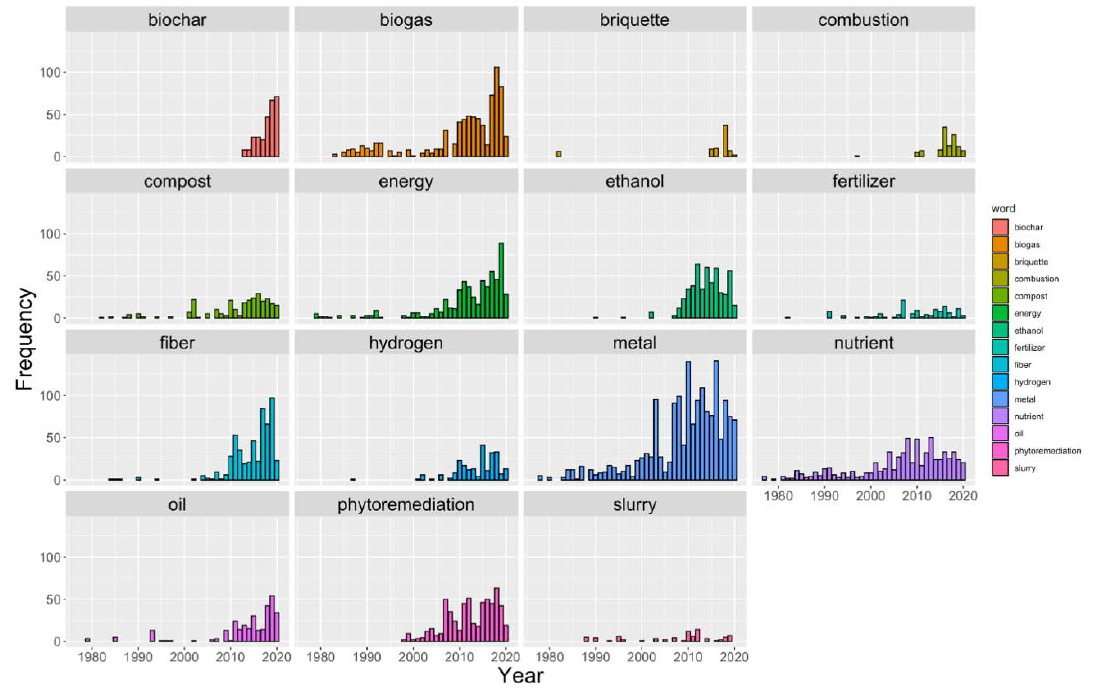
Figure 8. Occurrence of different terms in water hyacinth research over time.